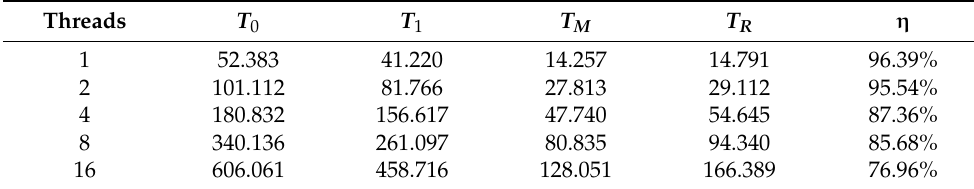
Table 3. The first three columns of the table present detailed results on the MPI-dependent per- formance of the computational domains of the three grid structures, with reference throughput T R and nesting efficiency \ eta calculated from these data, and the results were used to evaluate parallel